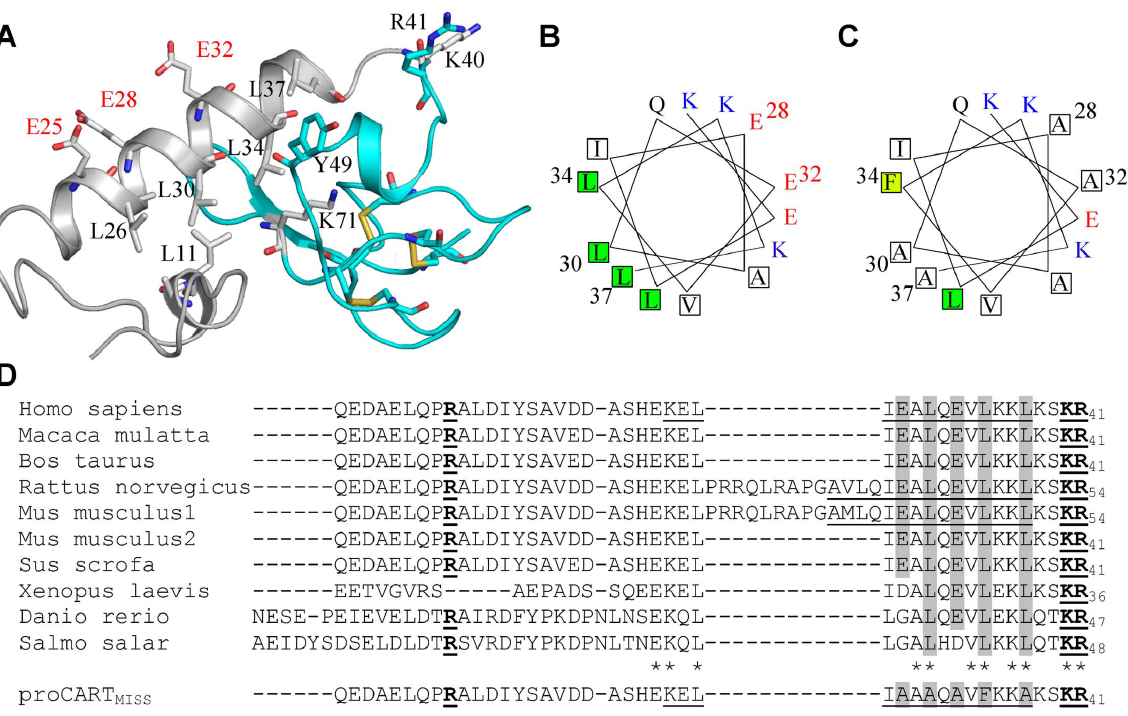
Figure 3. Insilico modeling of proCART. (A) proCART was modeled starting from the NMR- derived CART 48–89 structure (cyan). The modeling of the N-terminal region (gray) yielded an alpha-helix domain formed by residues 24–37. Disulfide bonds are indicated in yellow. (B) Helical wheel projection of proCART alpha-helix formed by residues 24–37. Leucines are indicated in green, glutamates in red and lysines in blue. (C) Helical wheel projection of proCART MISS . Substituted residues are shown in squares. Alanine substitution decreases the amphipathicity. (D) Alignment of proCART from several species. proCART alpha-helix structures predicted by NPS@ server (amino acids 24–37 for human, and 36–50 for rodent isoform are underlined. Residues modified in proCART MISS are highlighted in gray. Asterisks show conserved residues among species. The basic sites involved in proCART processing are bolded and